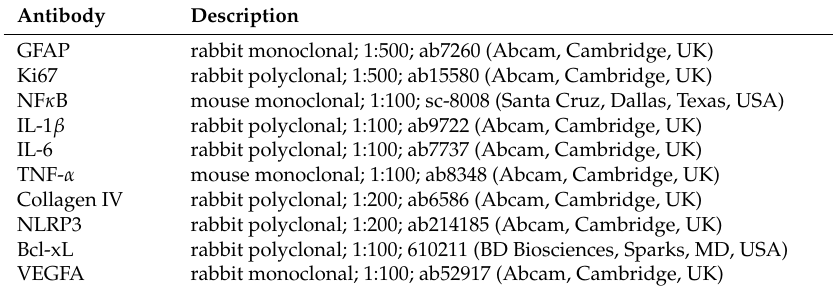
Table 3. Targets, dilution, and sources of applied primary antibodies in immunofluorescence.